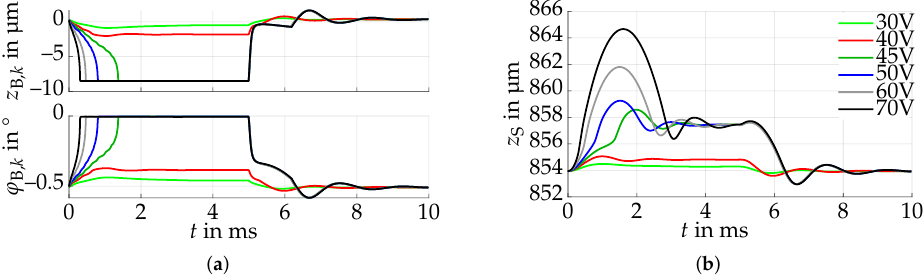
Figure 4. Model-based simulation of the beam and sphere motion when applying rectangular voltage pulses with amplitudes between 30V–70V to all beams. After 5ms, the input is reduced to zero. ( a ) The electrostatic force pulls the actuator beam downwards (top figure). Due to the leverage effect at the front end of the ground plate, the beam angle increases (bottom figure). For voltages larger than 44V a pull-in occurs, leading to a fast kick motion. ( b ) The upwards motions of the beam tips result in a change in the z -position of the sphere. For high voltages, a flight phase of the sphere is